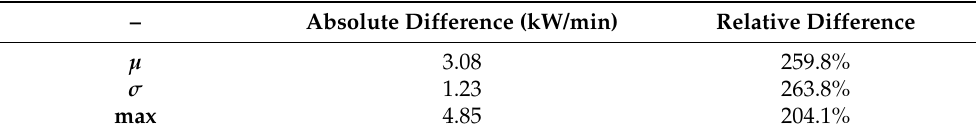
Table 11. Variation of daily peak of the absolute ramp of the active net power flow during May 2020 between Scenario B and Scenario A. µ : average value, σ : standard deviation, max: maximum